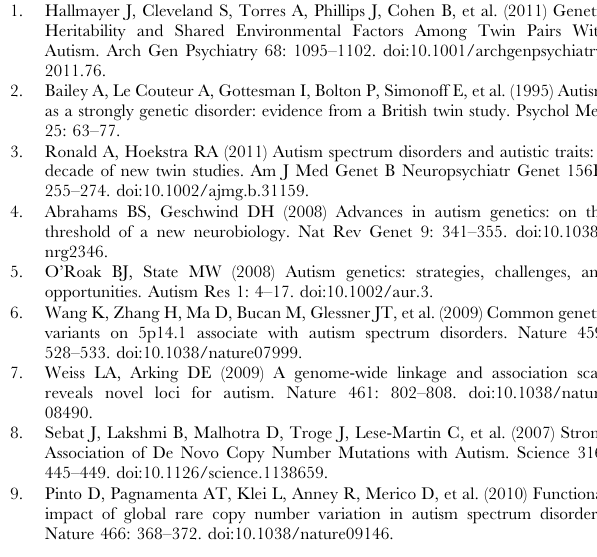
Table S5 For each module, a list of the top 10 brain regions with highest level of expression based on the module eigengene. Table S6 Top GWAS association signals in the SSC sample. Table S7 Replication attempts of published GWAS results in the SSC and AGP samples. Table S8 A list of candidate genes with gene-wide P - value , 0.05, which contributed to the enrichment of low GWAS p-values in the Lightgreen and Salmon modules. Table S9 A list of brain regions with gene expression microarray used to construct the gene co-expression